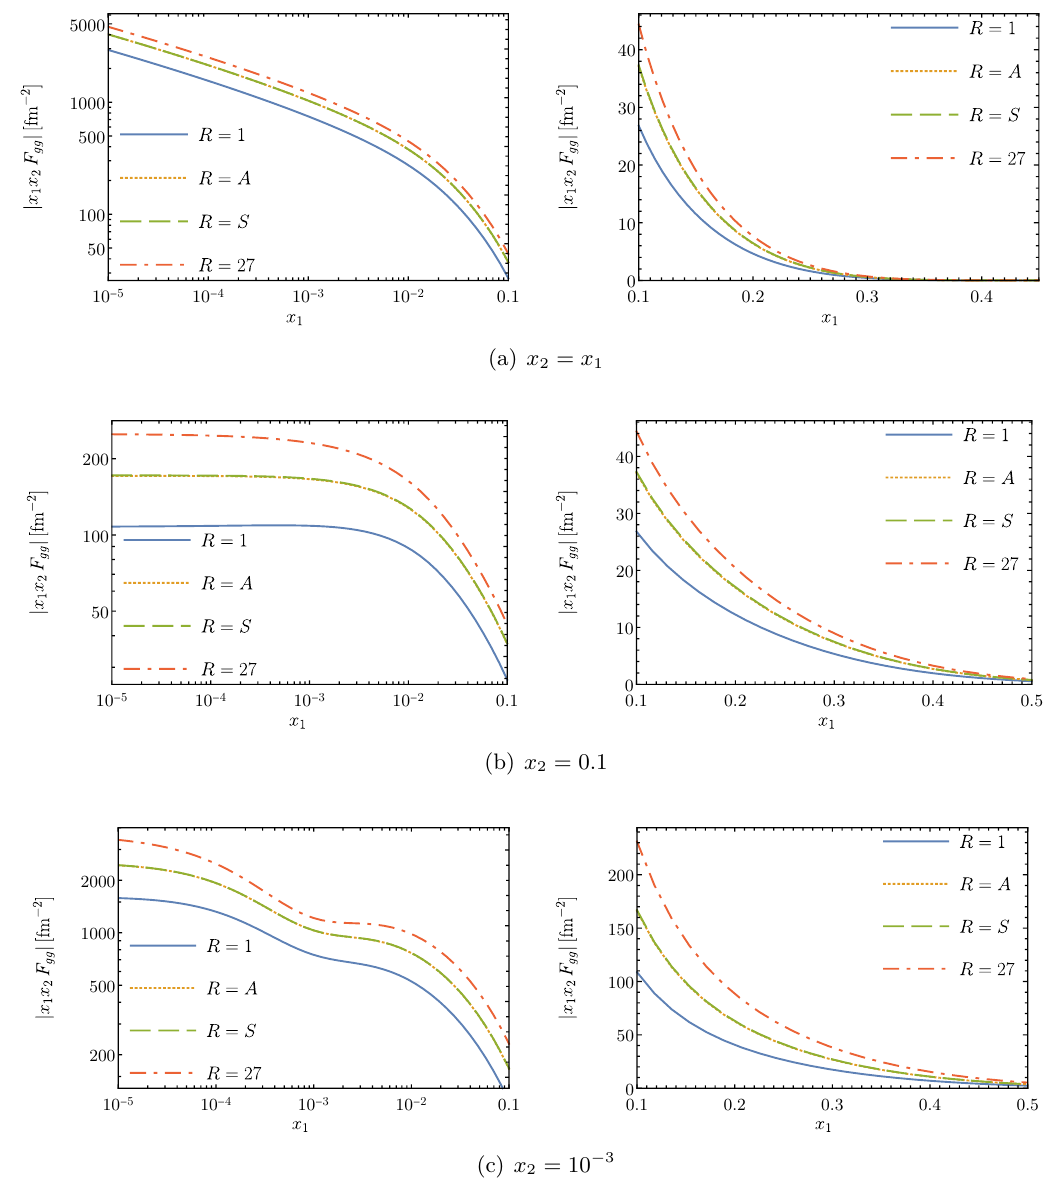
Figure 8 . Absolute value of the splitting DPD RR F (1) gg + RR F (2) gg evaluated at two-loop accuracy with central values µ = p x = µ of the scales. The curves for R = A and R = S cannot 1 x 2 ζ p y